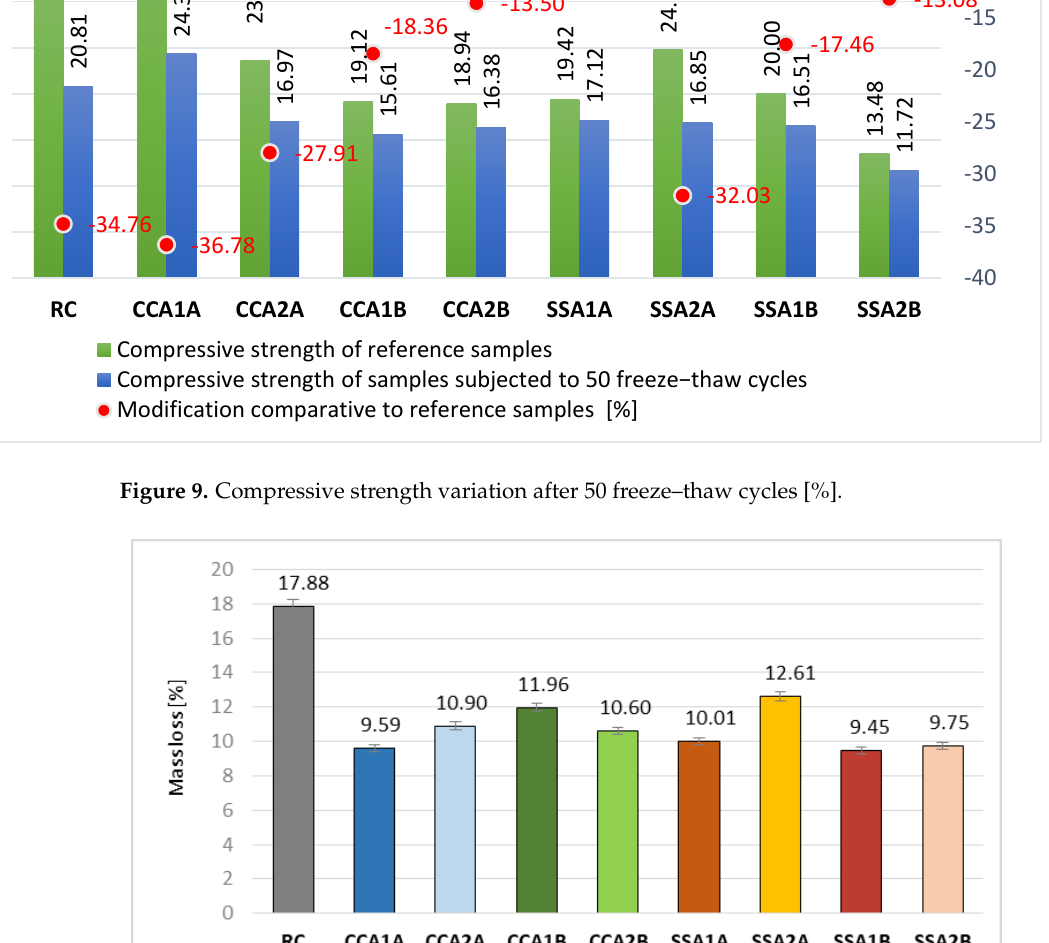
Figure 9. Compressive strength variation after 50 freeze–thaw cycles [%].